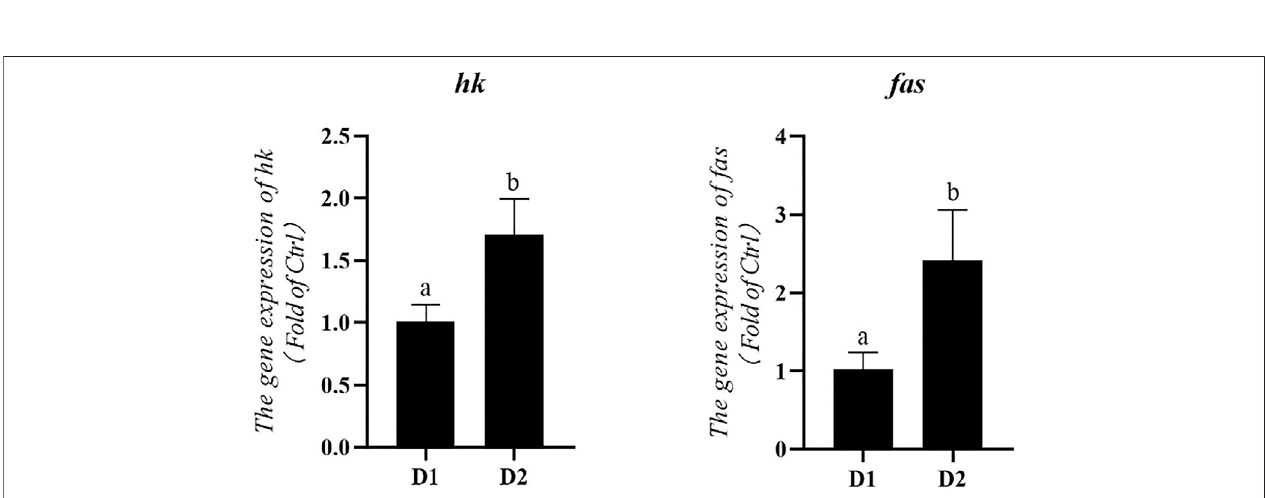
FIGURE 4 | Hepatopancreas mRNA levels of metabolic enzymes genes of L. vannamei fed diet supplemented with/without H. pluvialis GXU-A23 for 56 days. Values are mean ± SE ( n = 4). The small letters indicated signi fi cant differences at p < 0.05.